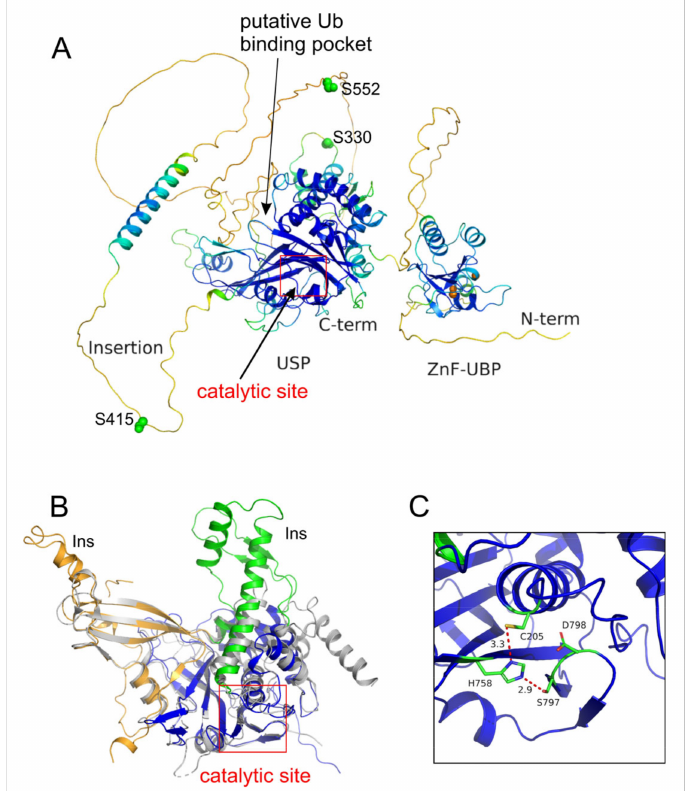
Figure 3. Structure of USP16. ( A ) AlphaFold-predicted structure of monomeric, full-length USP16 is colored according to the confidence of prediction (pLDDT value 0–100). Blue indicates high confidence. Zinc ions chelated to the ZnF-UBP domain are shown as orange spheres. Known phosphorylated residues, Ser330, 415, and 552, are presented as green spheres. ( B ) Superposition of the catalytic domains of USP16 (AlphaFold2 predicted) and USP7 (PDB: 1NB8) was carried out using PyMOL [29]. The fingers, thumb, and palm domain of USP16 are colored orange, green and blue, respectively. The USP7 catalytic domain is colored grey. While the core domains of USP7 and USP16 align well, it is evident that additional structural elements arise from the short insertions in